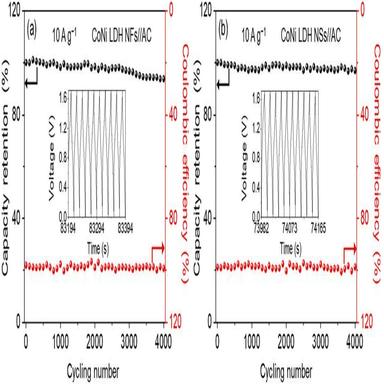
The capacity retention (black) and Coulombic efficiency (red) of (a) CoNi LDH NFs//AC HSC and (b) CoNi LDH NSs//AC HSC during 4000 cycles at 10 A g− 1 , and the insets presented the last 10 cycles. (For interpretation of the references to colour in this figure legend, the reader is referred to the web version of this article.)